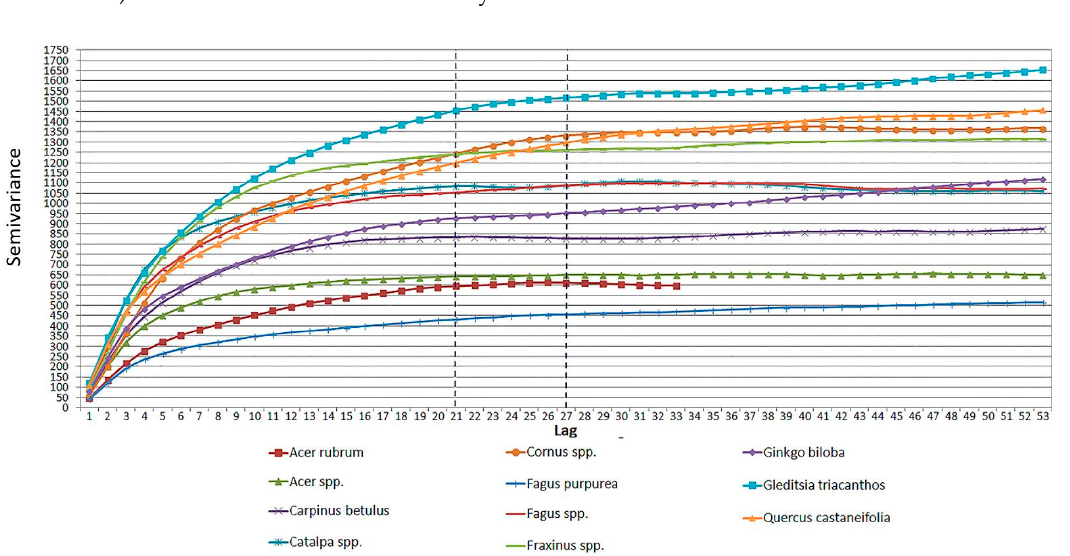
Figure 7. Tree species semivariograms.